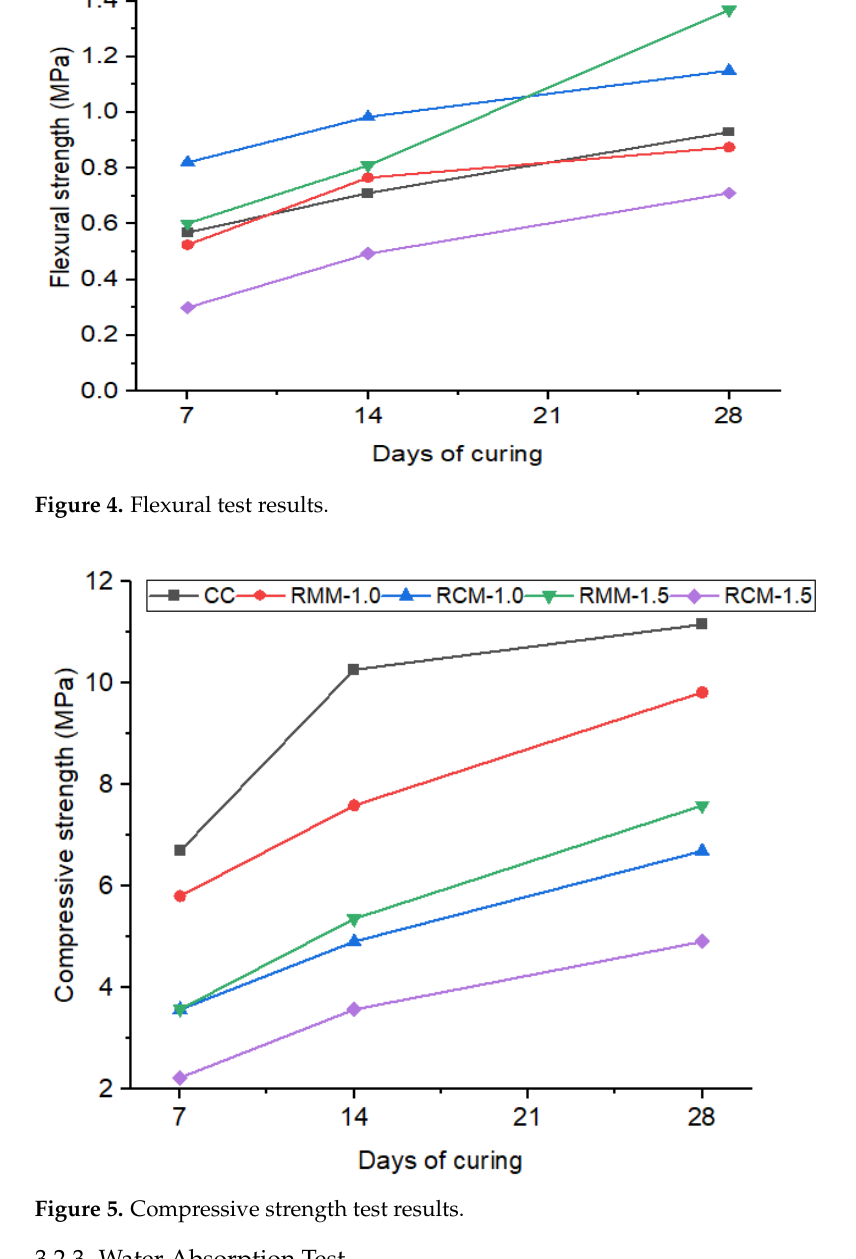
Figure 4. Flexural test results.